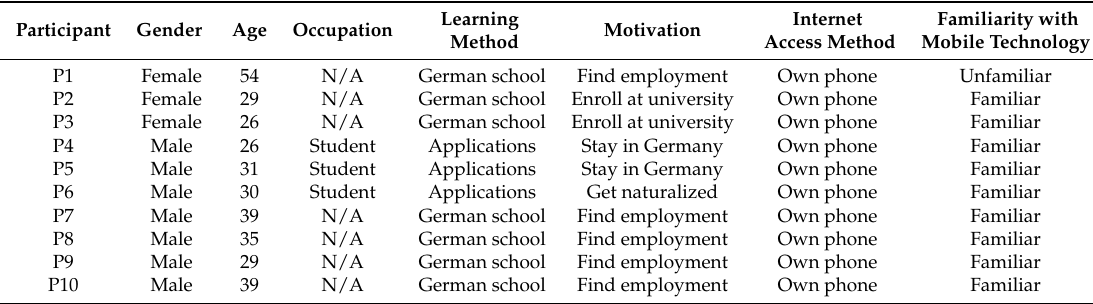
Table 2. How and why are the participants learning German in